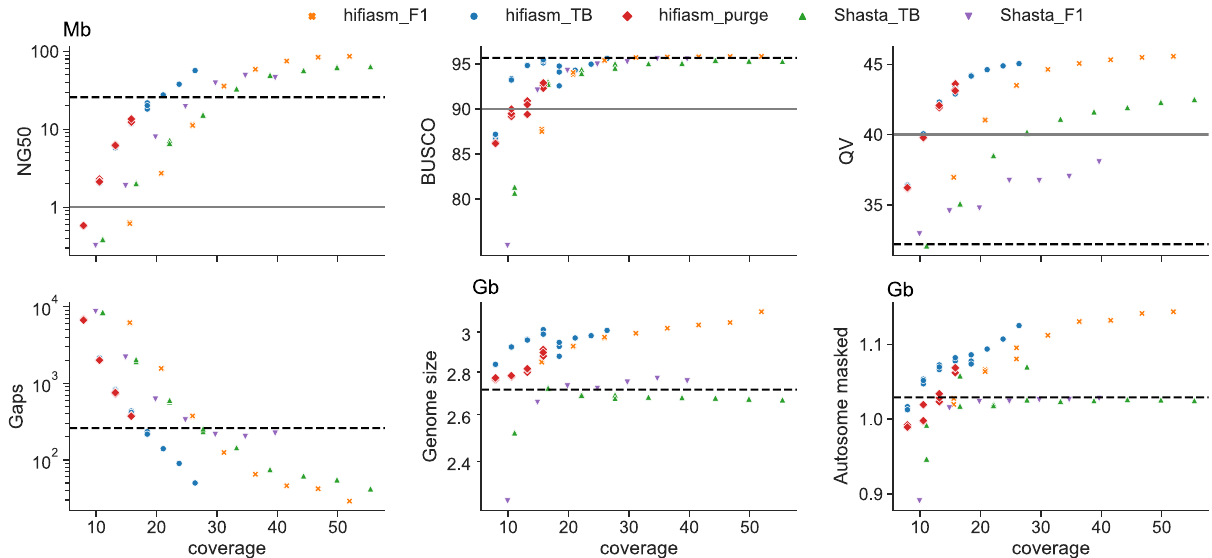
Fig. 3 Assembly quality at subsampled coverages. Trio aware hi fi asm (hi fi asm_F1) uses diploid coverage while Shasta (Shasta_TB) uses haploid coverage. We additionally examined trio binned hi fi asm (hi fi asm_TB) using haploid coverage and the polish-phased Shasta approach using diploid coverage (Shasta_F1). NG50, BUSCO, QV, autosomal gaps, and genome size are de fi ned in Table 1, while autosomal masked is the number of autosomal bases within repetitive elements as identi fi ed by RepeatMasker. The black dashed line represents the relevant value for the ARS-UCD1.2 reference and the gray solid line is the VGP target where applicable. Three subsampling replicates were performed for lower coverage assemblies (<20x for HiFi and <30x for ONT) due to their higher stochasticity. For trio binned hi fi asm assemblies below 15x coverage, we manually set the duplication purging parameter (hi fi asm_purge) and reran on the same